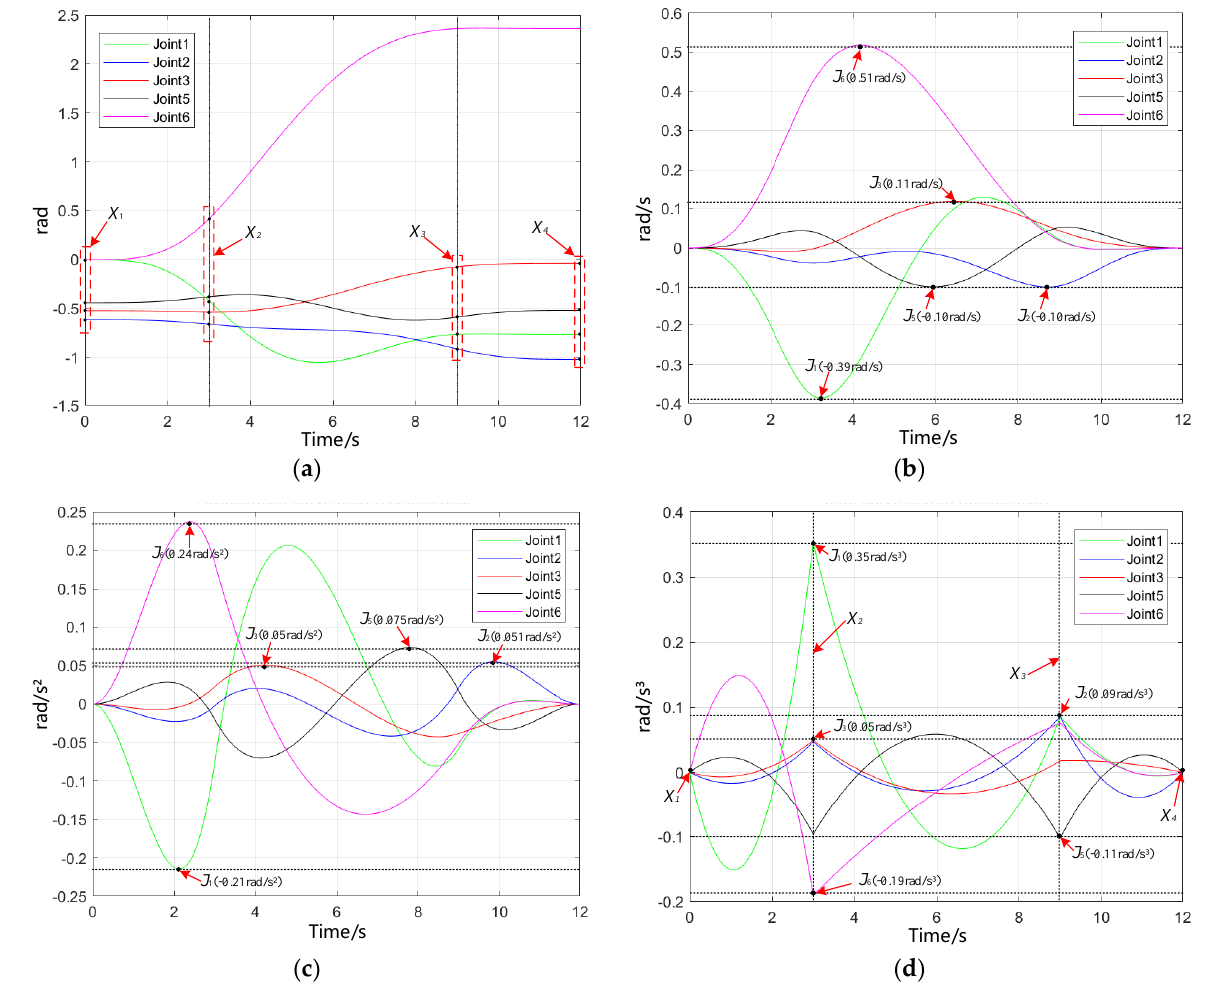
Figure 11. Joint motions before optimization: ( a ) Position curve; ( b ) Velocity curve; ( c ) Acceleration curve; ( d ) Jerk curve .